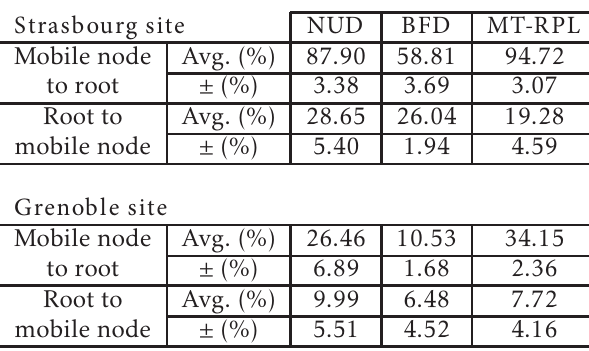
Table 2. Packet delivery ratio with 95% confidence